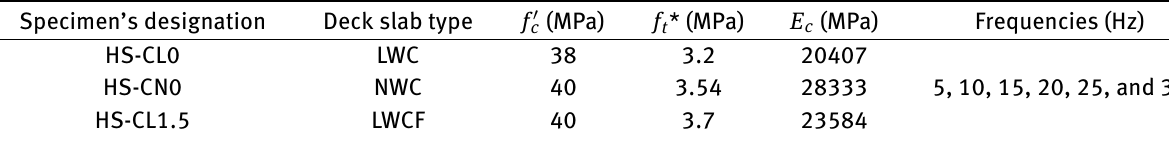
Table 3: Details of the tested specimens Specimen’s